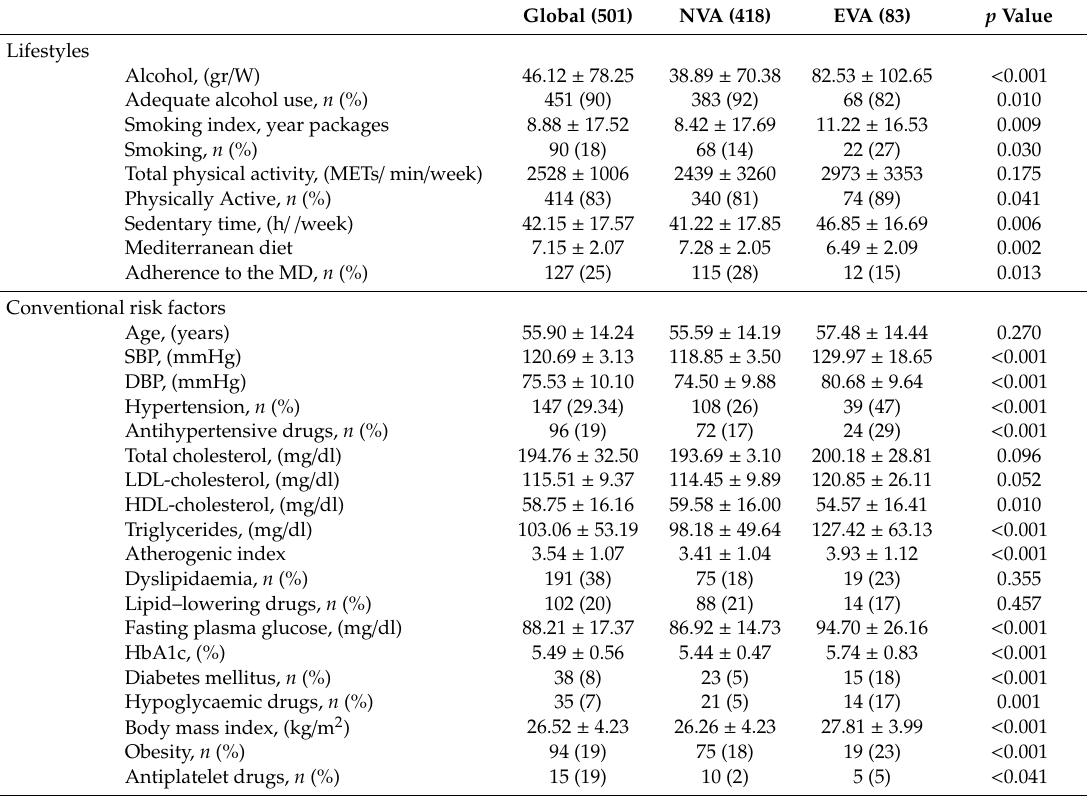
Table 2. Components of Mediterranean diet adherence by vascular aging.